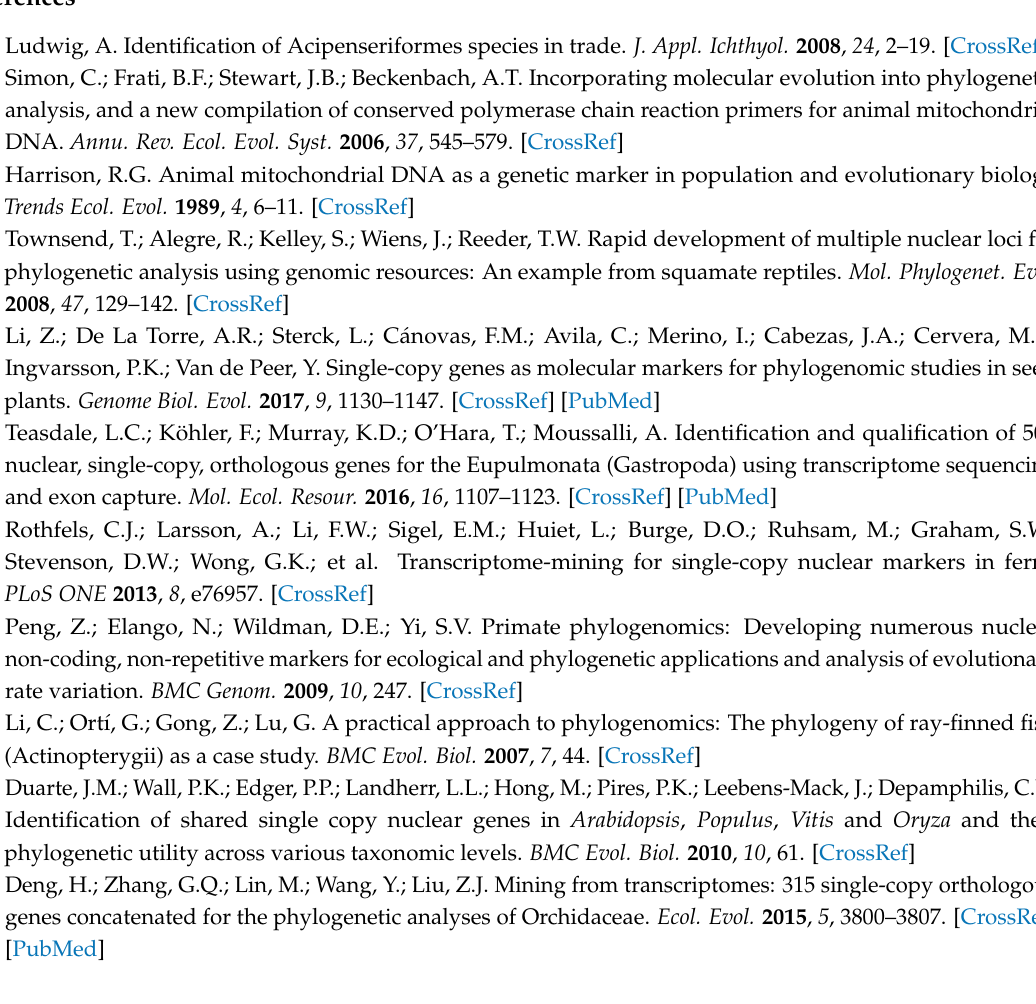
Figure S1: Flowchart for bioinformatics screening and experimental design, Figure S2: PCR amplification rendering of the 30 NPC markers in 16 Acipenseriformes species, Table S1: Transcriptome information of four sturgeons, Table S2: Maximum (U) and minimum (L) constrains (Mya) and calibration information for nodes in Figure 1 in the molecular dating analysis, Table S3: Number of predicted protein sequences (N) according to detected unigenes, Table S4: Summary information of 30 NPC markers, Table S5: List of GenBank accession numbers for the markers obtained in the present study, Table S6: Summary information of 30 NPC markers in 16 species of Acipenseriformes, Table S7: Saturation test performed by using DAMBE, Table S8: Detailed results of Bayesian molecular dating using MCMCTREE, and a comparison among shared nodes in previous